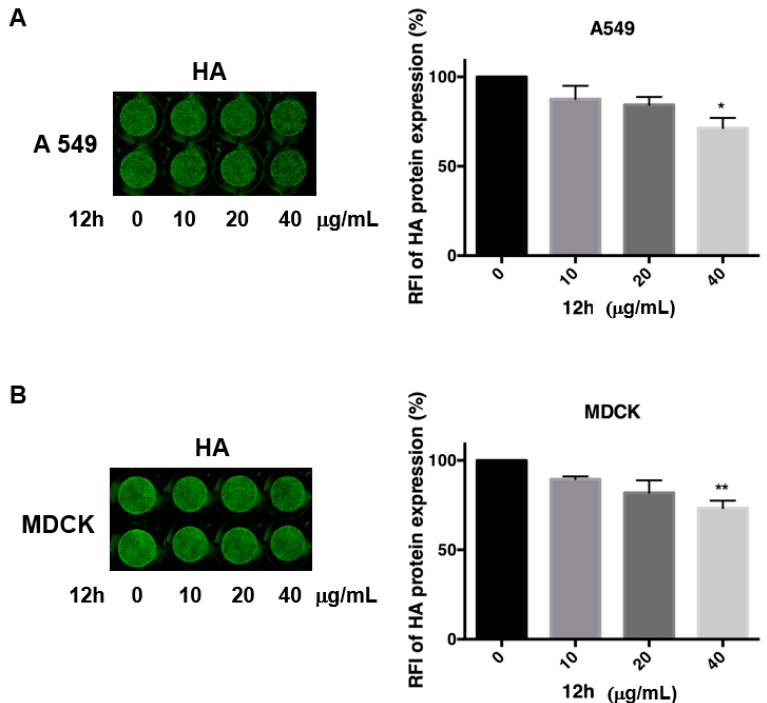
Figure 5. The expression of Hemagglutinin (HA) by means of In Cell Western (ICW) assay in the presence of most active compound 12h ; panel ( a ): A549 cells were infected with PR8 and treated or not with different concentrations (0–40 μ g/mL) of compound 12h . After 24 infection, cells were fixed and stained for HA protein, as described in the Materials and Methods section; panel ( b ): Supernatants were recovered and used to infect a fresh monolayer of MDCK (Madin-Darby canine epithelial kidney) cells. The expression of viral HA was analyzed by ICW assay, using LI-COR Image Studio Software. The percentage of relative fluorescence intensity (RFI) was calculated in comparison to untreated infected cells (considered 100%). Values are the mean ± S.D. of two replicates of one experiment of two performed (n = 2). Statistical significance of the data vs untreated infected cells was defined as * p < 0.05 and ** p < 0.001.